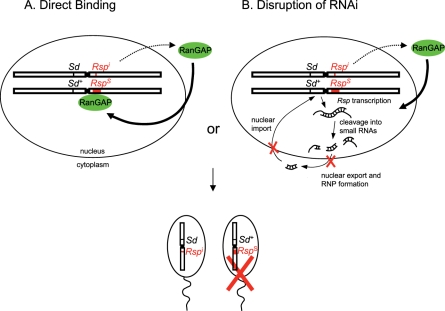
Two Models for the Role of Responder (Rsp) in Segregation Distortion (SD)The Sd gene encodes a truncated RanGAP, which mislocalizes to the nucleus. (A) In a previous model [14], nuclear RanGAP binds abnormally to Rsp satellite repeats on Chromosome 2 during spermatogenesis. Chromatin condensation is disrupted in chromosomes carrying a high number of repeats (Rsp
S), resulting in developmental failure of sperm bearing these chromosomes [16]. (B) Alternatively, SD is caused by disruption of an RNAi-dependent silencing process as suggested by Tao et al. [3]. Mislocalized RanGAP disrupts proper nuclear transport of small Rsp-derived RNAs and ribonucleoprotein (RNP) complexes that are required to repress the Rsp satellites. As a result, proper heterochromatic repression of Rsp
S is disrupted, causing defects in chromatin condensation and loss of Rsp
S-bearing sperm.